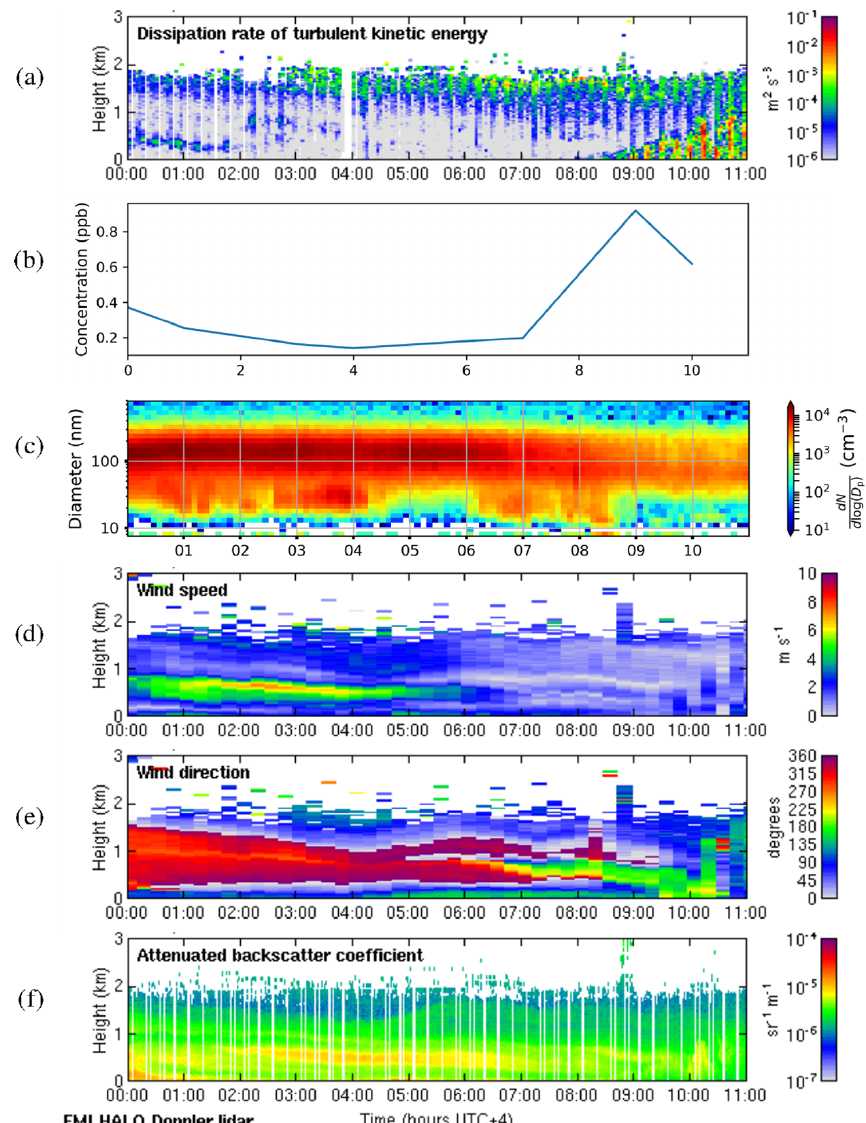
Figure D1. Deep-boundary-layer case with stagnant residual layer on 8 May 2018. (a) Time–height plot of dissipation rate of turbulent kinetic energy, (cid:15) ; (b) SO 2 concentration (ppb) measured at the surface; (c) aerosol particle size distribution measured at the surface (the colour indicates the concentration d N/ dlog( d p ) in cm − 3 ); and time–height plots of (d) wind speed, (e) wind direction, and (f) attenuated backscatter coefficient. For all panels, the time axis is local time (hours UTC + 4). The measurements in panels ( a, d, e , and f ) were obtained from the HALO Doppler